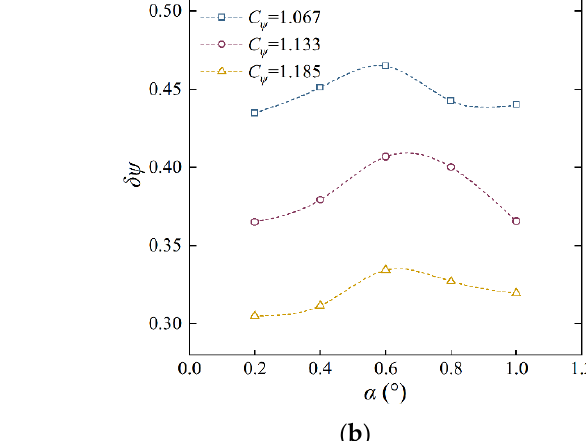
Figure 11. Pressure difference coefficient between the inlet and outlet of GV with respect to GV opening angle under conditions of different head coefficients. ( a ) GV-O; ( b ) GV-M.